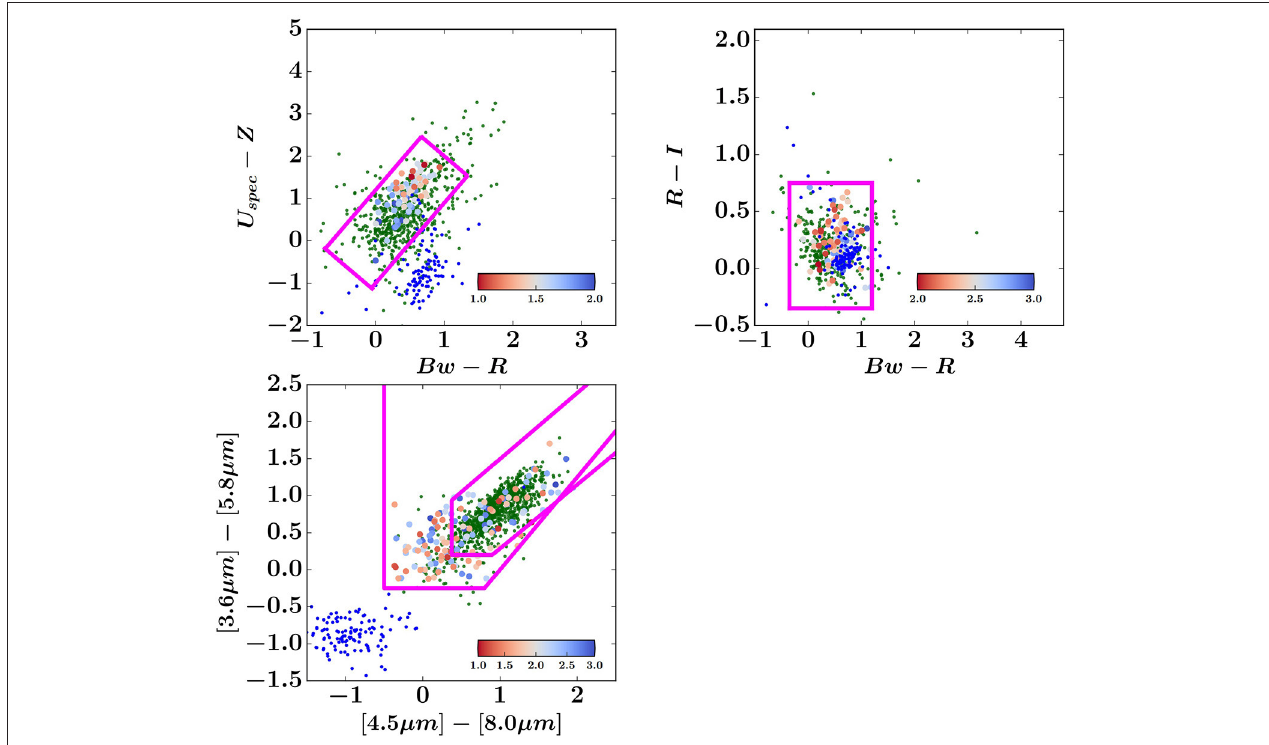
FIGURE 4 | Optical and mid-infrared colors for the candidate quasars identified within our selection regions (solid magenta lines). The color-scale indicates the photometric redshift for the candidate quasars. The dark green points represent all the spectroscopic quasars (both undetected and detected by LOFAR) in the Boötes region, while the blue circles mark the location of stars. The corresponding redshift bin is indicated by the colorbar legend.